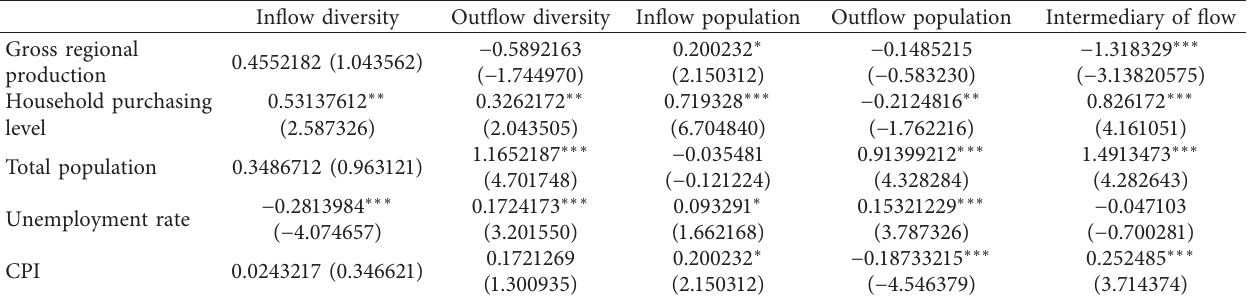
Table 7: Estimation of panel regression models by the least squares method (standardized coefficients and t ). Inflow